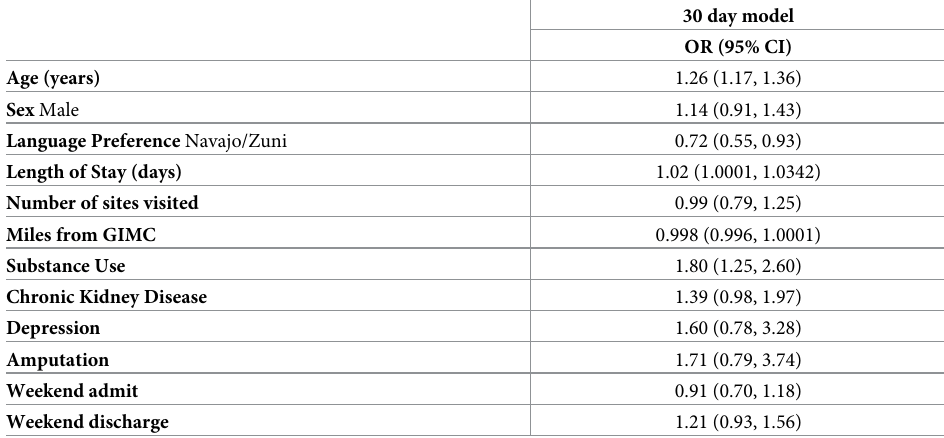
Table 2. Odds ratios, 95% confidence intervals, and p-values for covariates included in adjusted logistic regression models to identify risk factors for 30-day readmission models among American Indian patients with diabetes in the